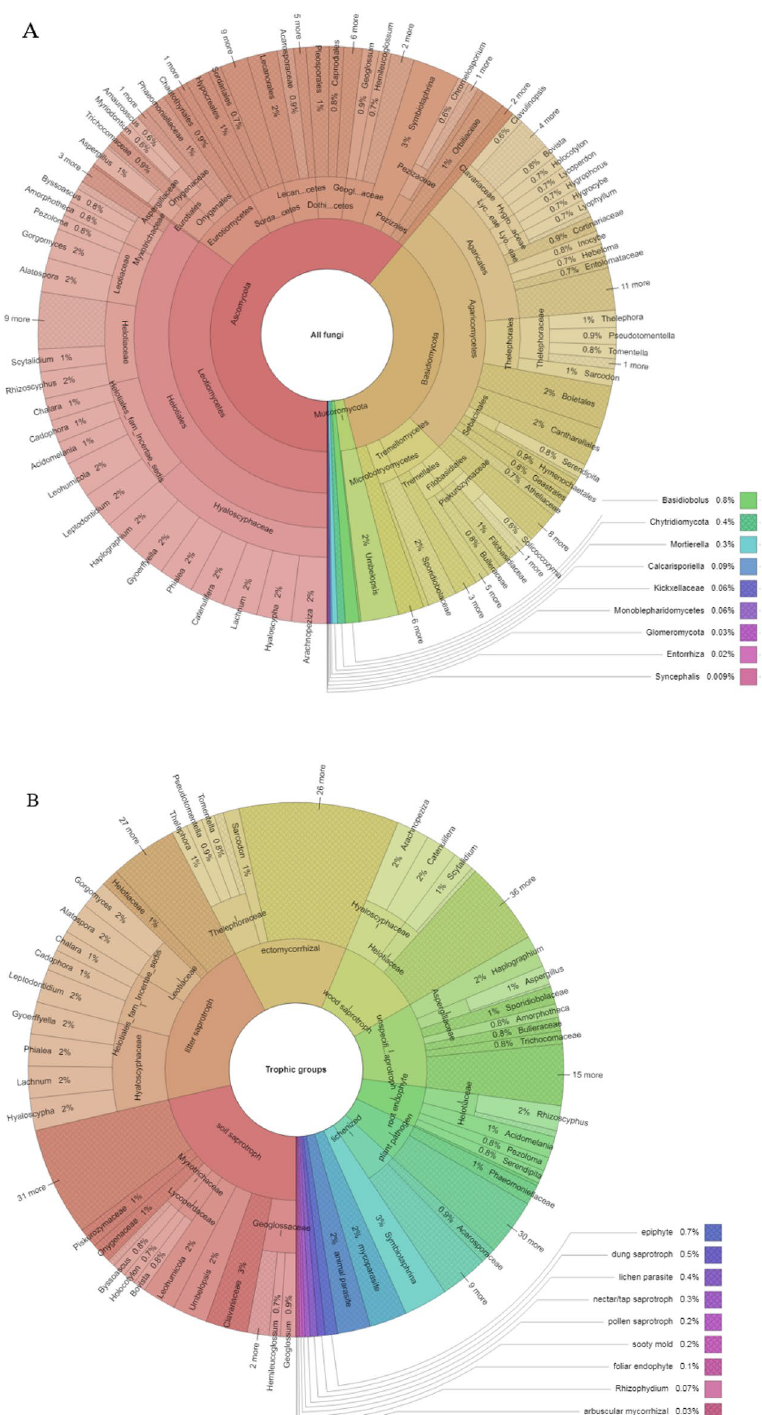
Figure 1. Krona charts showing fungal taxonomic classification in all treatments (prescribed, mechanical, and controls) at the phylum level ( A ) (name of phylum; number of OTUs; percentage); and ( B ) classification of fungal guilds based on the proportion of number of OTUs, including the taxa belonging to those guilds, based on Põlme et al. 45